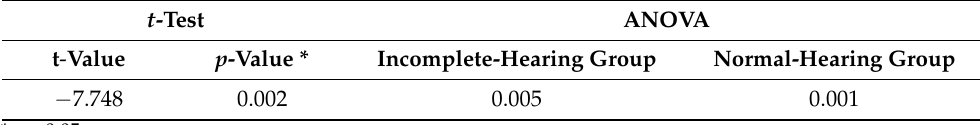
Table 13. Result of the T-Test and